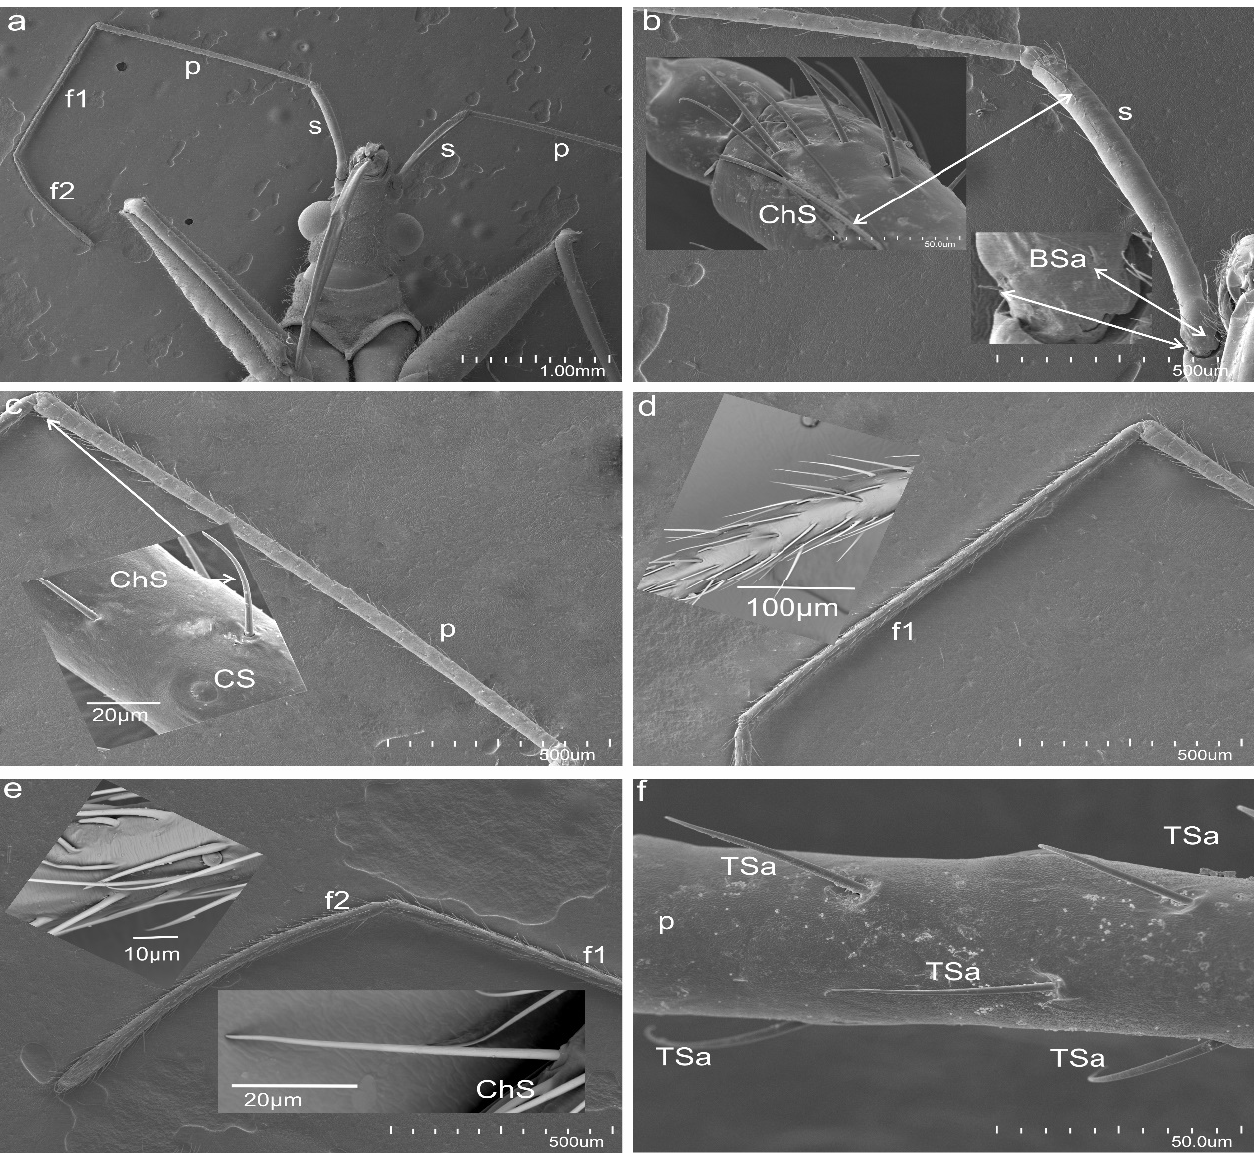
Figure 1. Photograph of N. rugosus antennae: ( a ) different antennal segments (scapus (s), pedicel (p), first flagellum (f1), second flagellum (f2)); ( b ) magnification of sensillum types of the scape; chaetic sensillum (ChS) and basiconic sensilla aporous (BSa). ( c ) Magnification of sensillum types of the pedicel (p); chaetic sensillum (ChS) and campaniform sensillum (CS). ( d ) Magnification of the first flagellum (f1). ( e ) Magnification of sensillum types of the second flagellum (f2); chaetic sensillum (ChS). ( f ) Magnification of sensillum types of the proximal part of the pedicel; trichoid sensilla (TSa). Scale bar members of the antenna ( b – e ) show the same magnification.